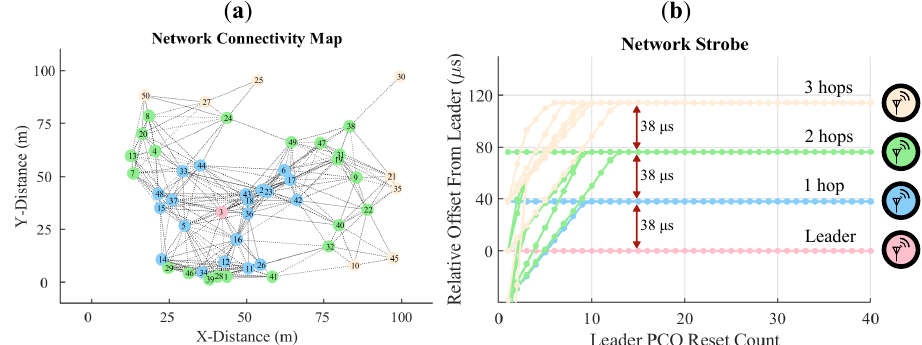
Figure 8. ( a ) Network of 50 nodes generated by a uniform distribution with a 30m effective range on a 100 by 100 m grid. ( b ) PCO reset offset of the 50 nodes relative to the fastest (leader) node across 40 leader cycles. Synchronization is achieved within the first 15 cycles, after which maximum synchronization latency is 38µs between successive